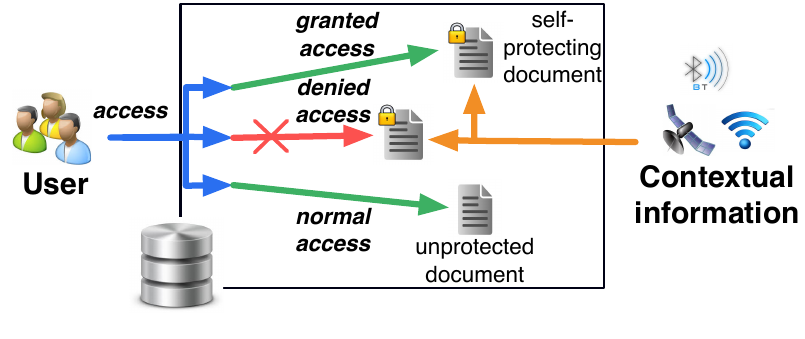
Figure 1. SmartContent approach.